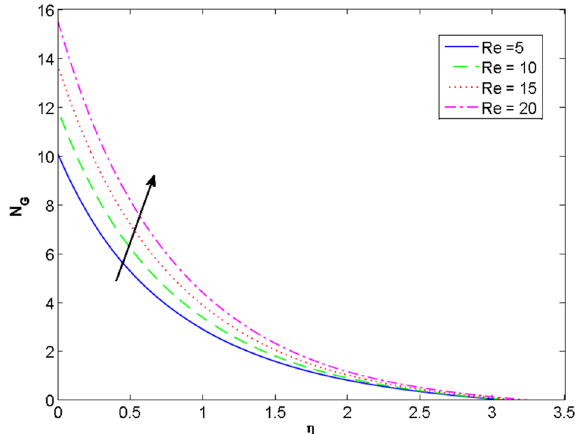
Figure 16. Profile of N G versus Re .